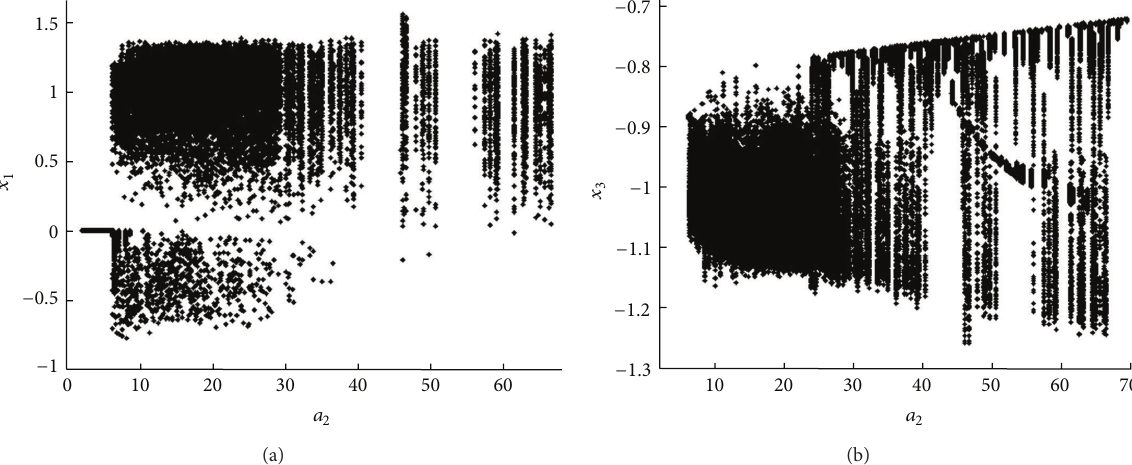
Figure 8: The bifurcation diagram is obtained for the in-plane excitations 𝑎 2 = 2 ∼ 70, 𝑓 2 = 55.1 , 𝜇 1 = 0.1 , and 𝜇 2 = 0.1 ; (a) the bifurcation diagram on the plane (𝑥 1 ,𝑎 2 ) ; (b) the bifurcation diagram on the plane (𝑥 3 , 𝑎 2 )